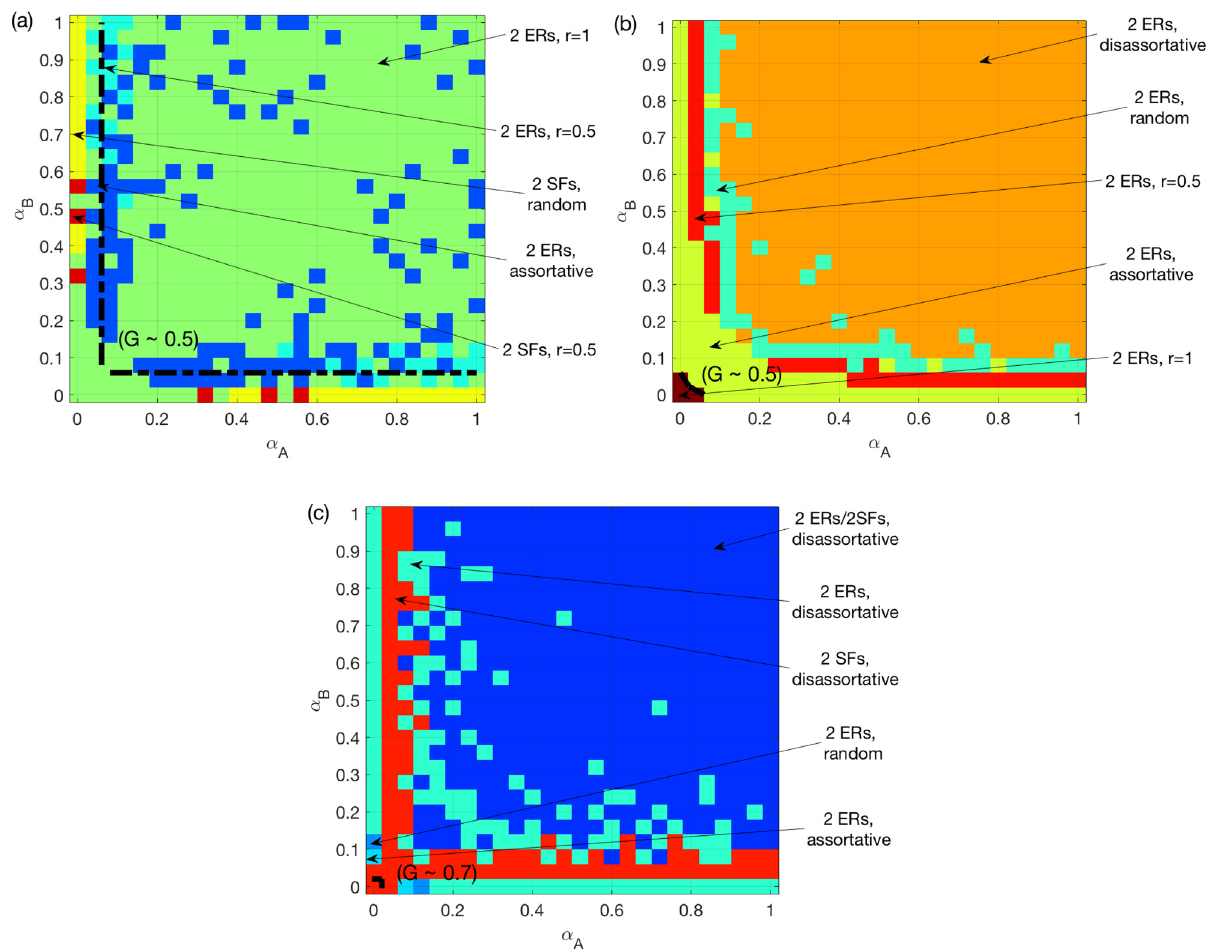
Fig 8. Best choice of network structures and coupling schemes. (a) OR rule. (b) SUM rule. (c) AND rule. N = 500, k A = k B = 6, averaged over M = 50 realizations. The color for certain α A and α B values indicatesthe best type of networksand couplingscheme having the largest mean G value. A dashedline is added to each sub-figureto indicatethe locationwhere the best mean G reaches0.5, and 0.7 for (c).